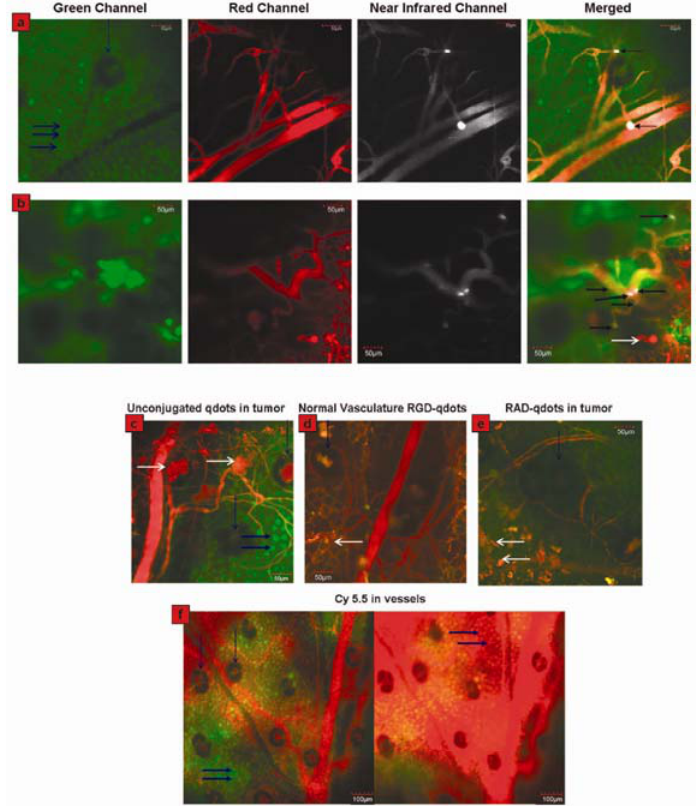
Figure 6. Direct visualization of binding of RGD-QDs to tumor vessel endothelium and controls. ( a ) Panel displays different output channels of the identical imaging plane along the row with scale bars. In the green channel, individual EGFP-expressing cancer cells are visible (marked by thick horizontal blue arrows; vertical blue arrow points to a hair follicle), while the red channel outlines the tumor’s vasculature via injection of Angiosense dye. The NIR channel shows intravascularly administered QDs, which remain in the vessels ( i.e. , they do not extravasate). Binding events are visible by reference to bright white signal. These are demarcated by arrows in the rightmost merged image, in which all three channels have been overlaid; ( b ) Displays the same as ( a ) in a different mouse, except that six times the RGD-QDs dose has been injected. Individual cells are not generally visible. Six binding events are observed in this FOV, as marked by arrows in the merged image at right. White arrows in the bottom merged image designate areas of tissue autofluorescence. Typical images of no binding in each control condition are shown in ( c – f ). Tumor neovasculature containing unconjugated QDs ( c ), normal vasculature containing RGD-QDs ( d ), and tumor neovasculature containing RAD-QDs ( e ). ( f ) Tumor vasculature shortly after Cy5.5 injection (left) and ~20 min post-Cy5.5 injection (right). Individual cancer cells are visible before (left) and after dye extravasates (right, dyed red). Also see movie S6 in Supporting Information. Horizontal white arrows indicate tissue autofluorescence, vertical blue arrows denote hair follicles (which generally display autofluorescence in their center), and thick horizontal blue arrows indicate individual cancer cells. Reprinted with permission from [41]. Copyright 2008 American Chemical